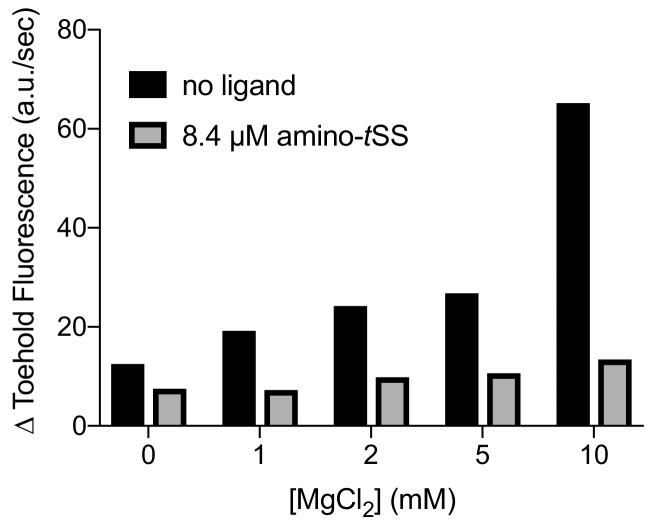
Co-transcriptional binding of a ribosome-mimic in vitro under various Mg2+ conditions.Whereas the rate of transcription increases with magnesium (black), the bound state (gray) does not change significantly, suggesting that co-transcriptional binding is minimally affected by magnesium concentration.Figure 2—figure supplement 2—source data 1.Effect of Mg (II) on toehold binding by Were-1 in absence and presence of amino-tSS.